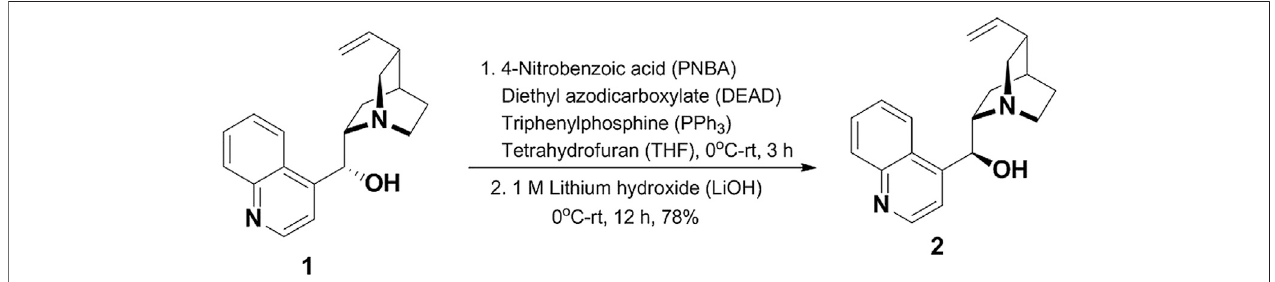
FIGURE 2 | Synthetic route of epi